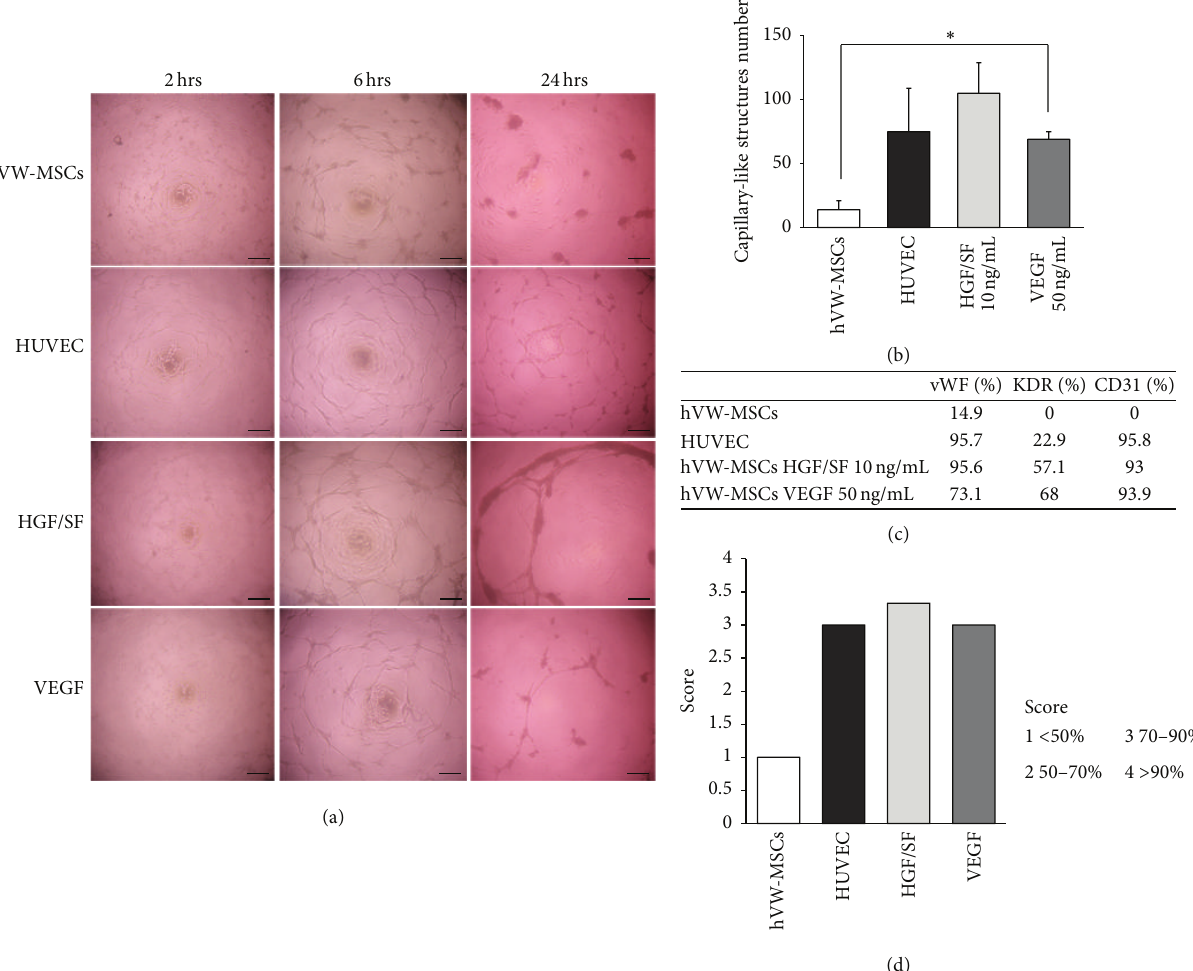
Figure 5: Angiogenic effect of HGF/SF on hVW-MSCs. (a) Representative in vitro tube-like formation images of HGF/SF (10ng/mL for 7 days) and VEGF (50 ng/mL for 7 days) preconditioned hWV-MSCs as well as uninduced hWV-MSCs and HUVEC in Matrigel assay for 2, 6, and 24 hrs from seeding. Scale bars = 100 𝜇 m. (b) The quantitative analysis of the capillary-like structures revealed a higher number of hVW-MSCs exposed to HGF/SF than VEGF-treated cells. ∗ 𝑝 value < 0.05; Student’s t -test. (c) Flow cytometry analysis of von Willebrand factor (vWF), KDR, and CD31 expression on untreated hVW-MSCs, HUVEC, and HGF/SF- and VEGF-treated cells. (d) The angiogenic lineage commitment was evaluated for each treatment attributing a score from 0 to 4 according to flow cytometry